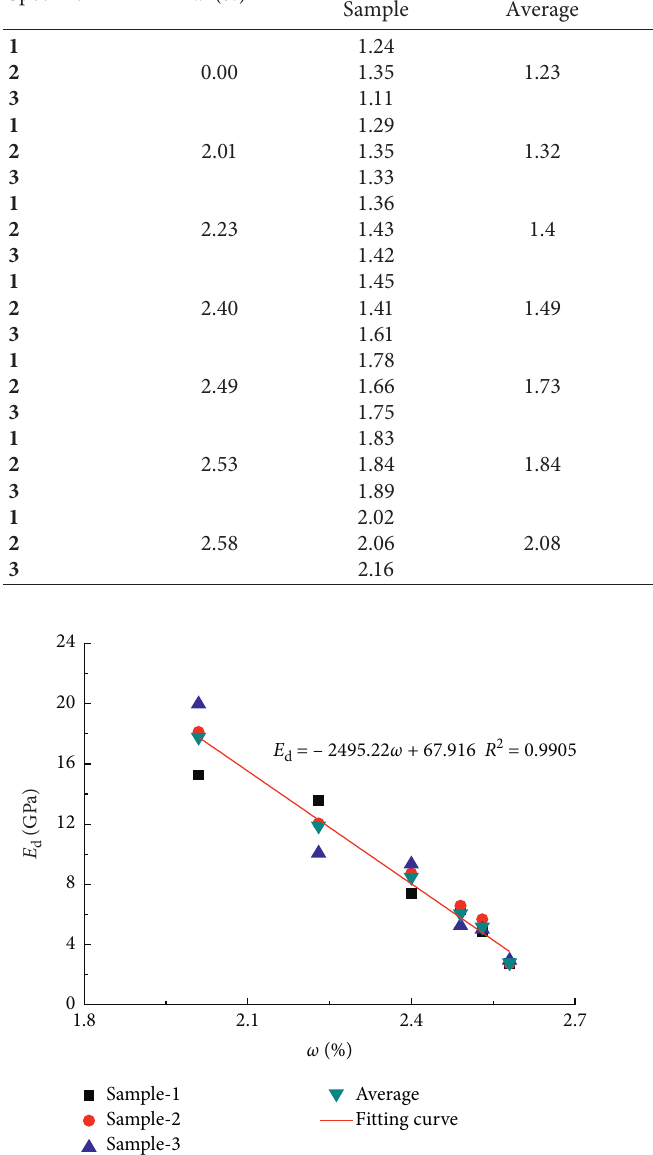
Table 2: Effect of moisture content on dynamic peak strain, dynamic peak strength, and dynamic elastic modulus. Specimen